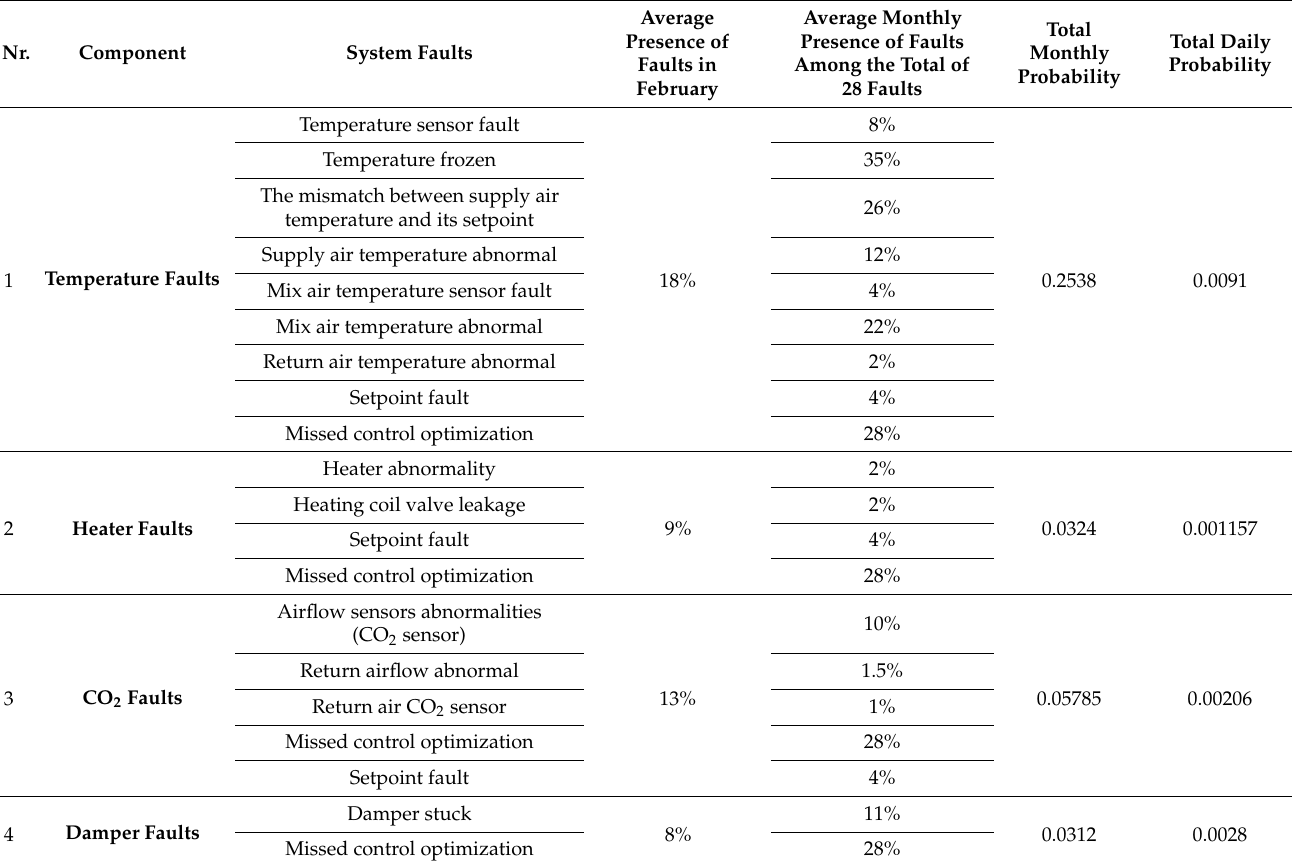
Table 4. The faults and their fault occurrence incidents for the associated fault